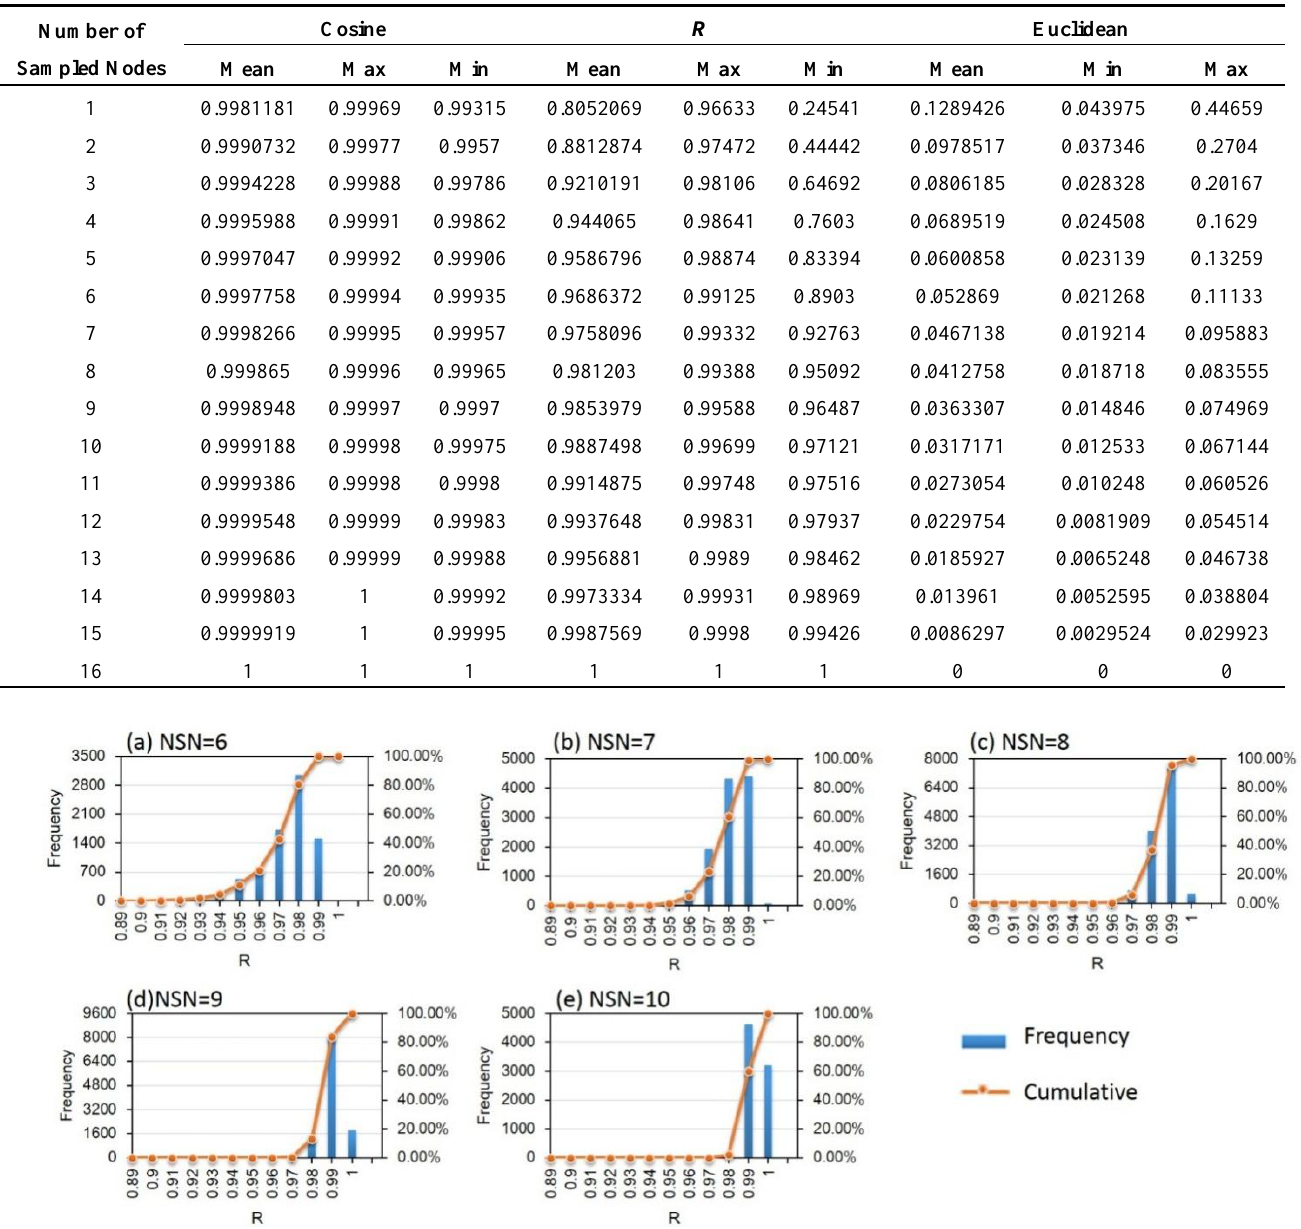
Table 2. The mean, max and min value of angular cosine (Cosine), correlation coefficient ( R ) and Euclidean distance (Euclidean) of all the possible combinations for different number of measurement nodes.